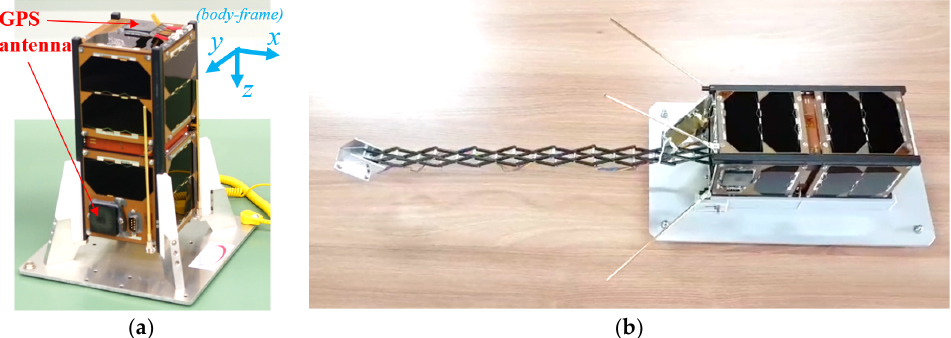
Figure 1. ( a ) SNUGLITE CubeSat before deployment; ( b ) SNUGLITE CubeSat after deployment.